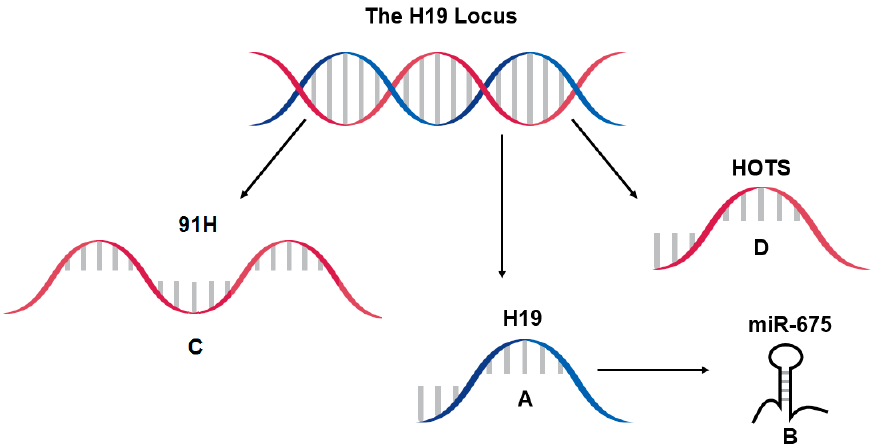
Figure 1. Transcription at the H19 locus consists of the well-characterized H19 lncRNA ( A ) and its microRNA miR-675 ( B ) encoded within the first exon of H19 . Two antisense transcripts are also formed from the locus. 91H RNA ( C ) is described as varying in length, but can potentially be encoded from the other DNA strand entirely encompassing H19 and other portions of its regulatory sequences. HOTS RNA ( D ) is transcribed from most of the antisense sequence of H19 and upstream bases. HOTS can be translated to form a nucleolar protein.